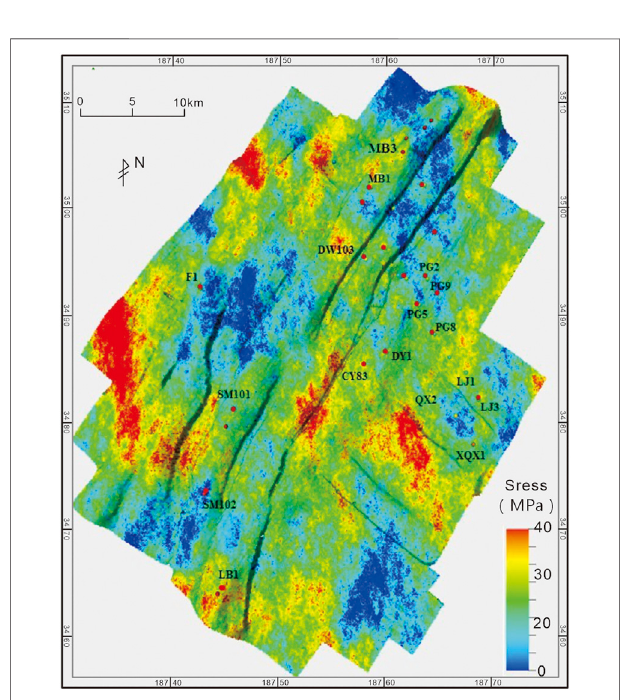
FIGURE 5 | The contour map of horizontal differential stress numerical simulated in the second member of Jialingjiang formation.